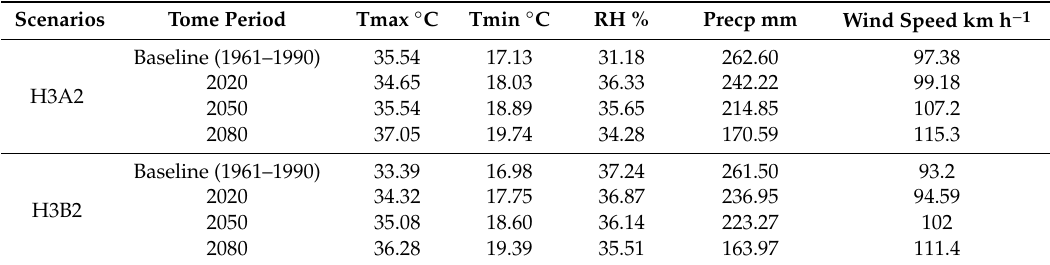
( a ) ( b ) Figure 5. Downscaled mean monthly values of climatic parameters (mean monthly Tmax (maximum temperature, Tmin (minimum temperature), Precp (precipitation), WDS (wind speed), and R.H (relative humidity)) in the baseline (1961 – 1990) and future (2020s, 2050s, and 2080s) under ( a ) H3A2 and ( b ) H3B2, scenarios. Table 4. Relative changes in average values of climatic parameters in future periods with respect to the baseline period (1961 – 1990).